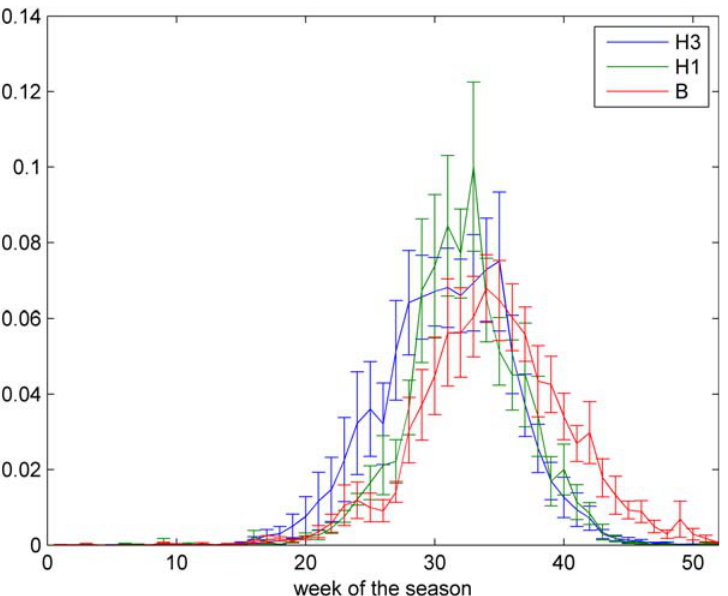
Figure 2. Mean aggregate incidence curves by type and subtype for the Northern Hemisphere. Weekly incidence values for each type and subtype were summed for the Northern Hemisphere for each of the nine study seasons and normalized as a percentage of the total number of isolates of that particular type or subtype recorded over the nine year study period. The average value for each week ( 6 SE) were plotted versus time for each type and subtype. The profiles clearly show that influenza B lags the other two subtypes (see text).